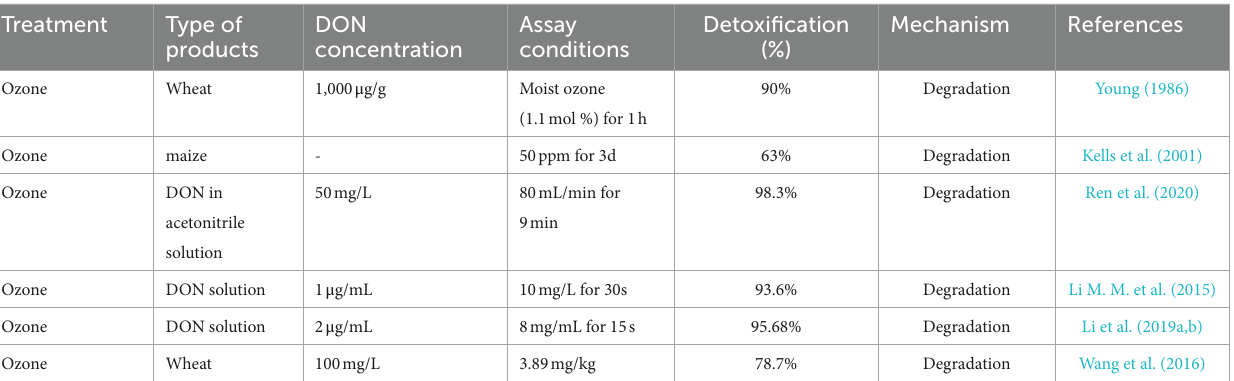
TABLE 2 Application of ozone in grain storage and